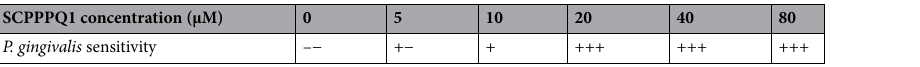
SCPPPQ1 concentration